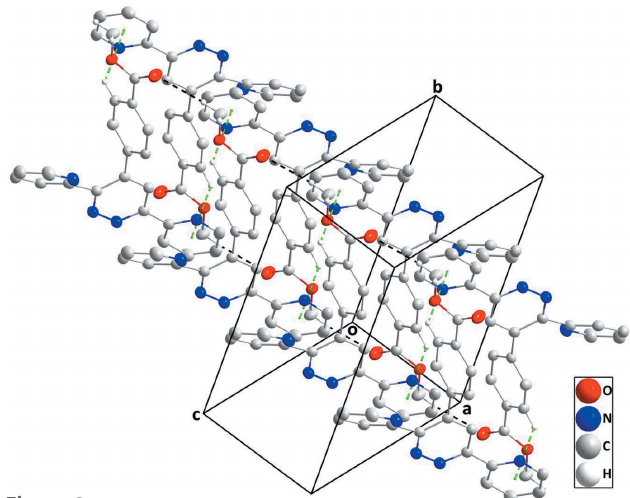
Figure 2 A partial packing diagram showing two chains connnected by C— H (cid:2)(cid:2)(cid:2) (cid:2) (ring) interactions (green dashed lines). The C—H Mthy (cid:2)(cid:2)(cid:2) O Carbx (Mthy = methyl and Carbx = carboxylate) hydrogen bonds are shown as black dashed